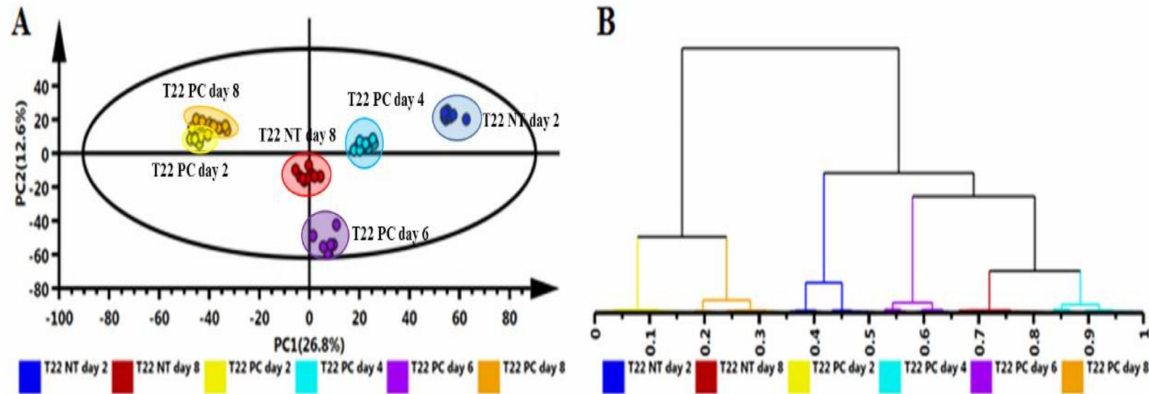
Figure 4. Unsupervised statistical modeling of leaf data comparing plants primed by Paenibacillus alvei T22 and primed and challenged with Phytophthora capsici. ( A ) A principal component analysis (PCA) scores scatter plot of all the samples, includ- ing the QC samples, colored according to time points: T22 NT, day 2 (blue) and day 8 (brown) and T22 inoculated and PC treated, days 2 (yellow), 4 (teal), 6 (purple) and 8 (orange). The PCA model presented here was a 7-component model, with R 2 of 0.739 and Q 2 of 0.664. ( B ) The hierarchical cluster analysis (HiCA) dendrogram corresponding to ( A ). Unsupervised sta- tistical analysis is used to generate subgrouping of samples based on similar observations in ( A ) while the HiCA dendrogram shows the hierarchical relationship between samples ( B ). Data were acquired in (–) electrospray ionization